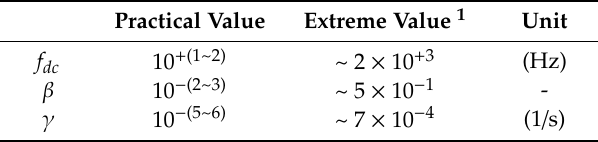
Table 1. Practical and extreme values of